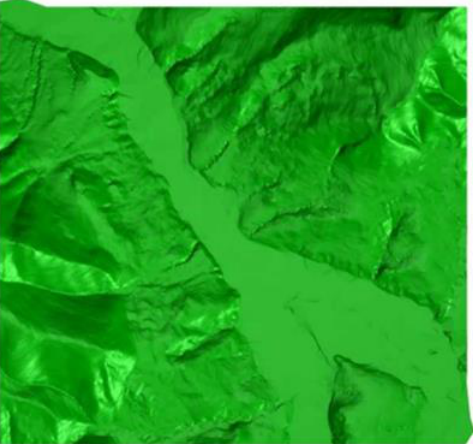
Figure 18. Digital terrain model — view from above, Phong type rendering with solar lighting from the southeast side.